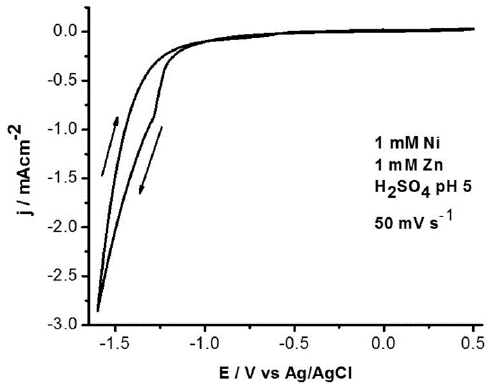
Figure 6. Cyclic voltammetry of 1 mM Ni and 1 mM Zn in H 2 SO 4 , pH 5 solution. Scan rate: 50 mV·s −1 .